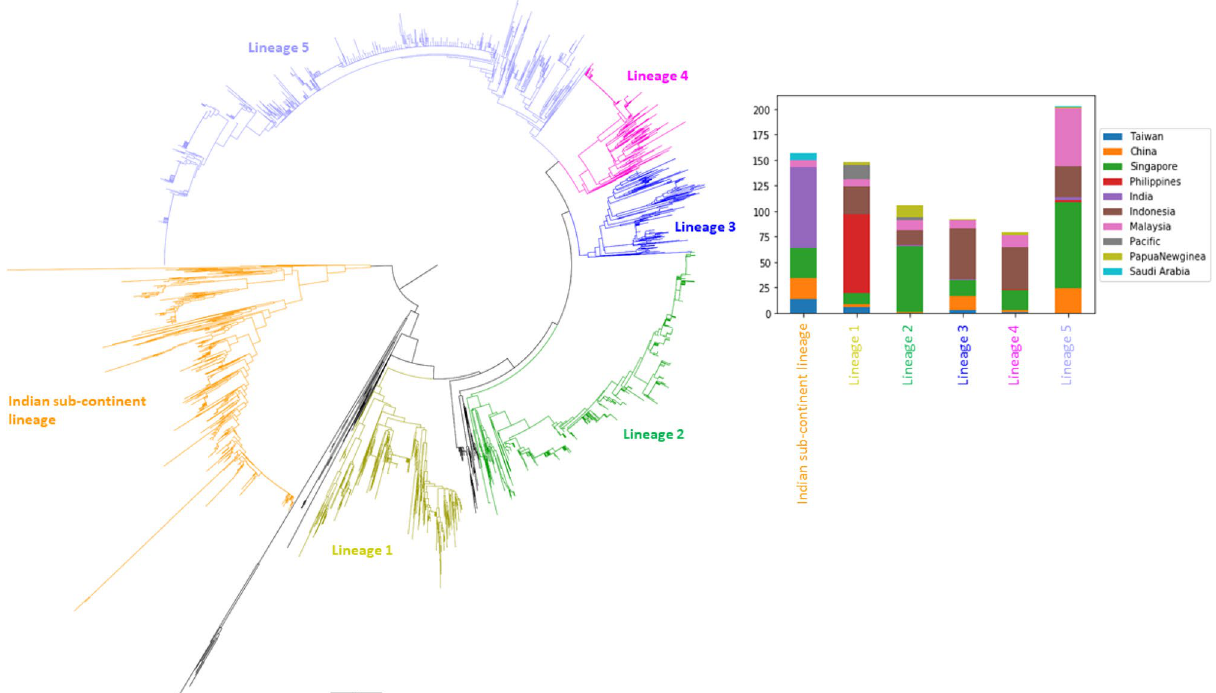
Figure 4. Phylogenetic analysis of E gene sequences of cosmopolitan genotype. The neighbour joining tree was constructed by using 3367 complete E gene sequences. The alignment included 2319 sequences retrieved from NCBI database and 1048 sequences generated during the present study. Distinct lineages are shown in different colours. Sequences that were not classified into any distinct lineage are shown in black branches. An expanded tree that illustrates the distribution of newly generated sequences obtained from human sera and field-caught mosquitoes is given in Supplementary Fig S3. The inset bar chart represents geographical distribution of each lineage.